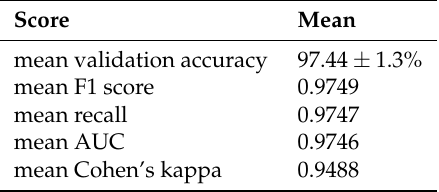
Table 4. Efficacy of the mine and dam localization model for 10-fold cross validation.